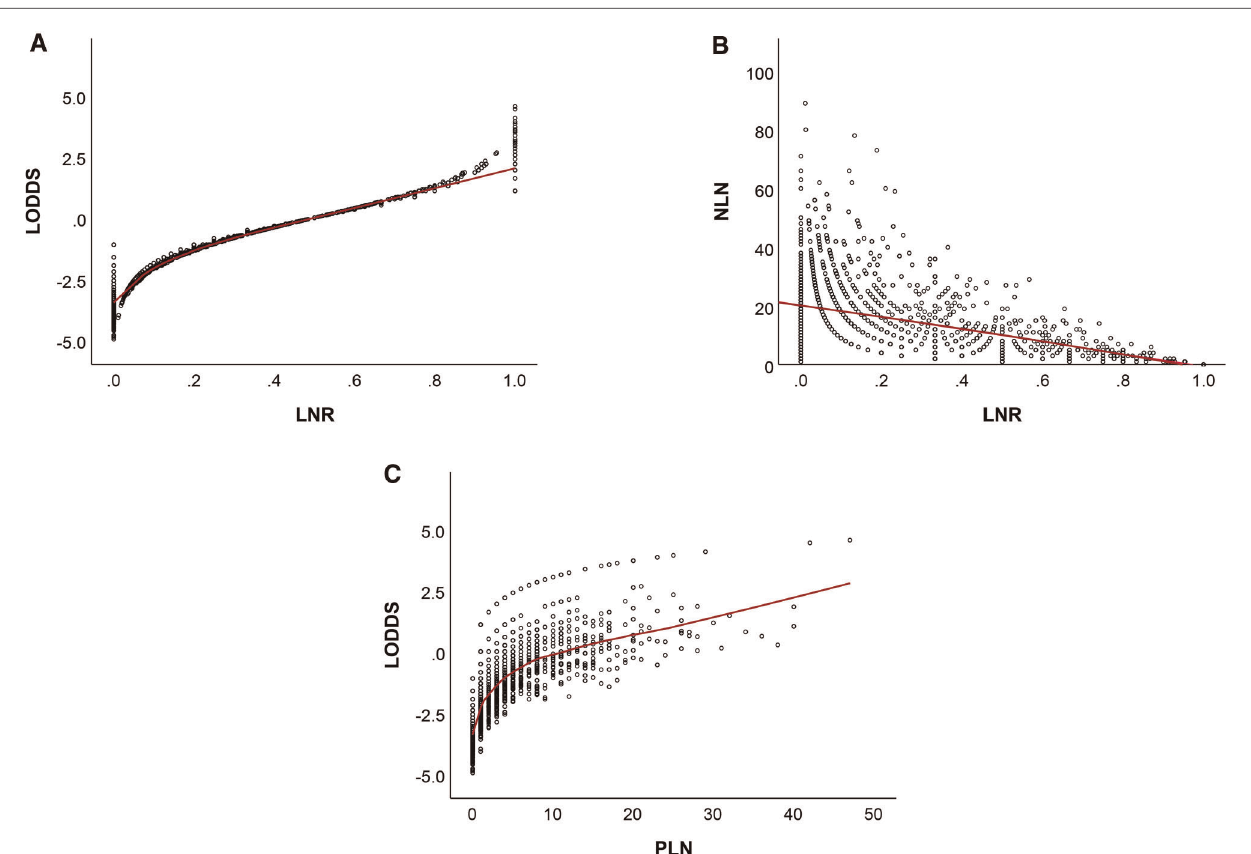
FIGURE 8 | Distribution of LNR vs LODDS ( A ), NLN ( B ), and PLN vs LODDS ( C ). LNR, lymph node ratio; LODDS, log odds of positive lymph node; NLN, negative lymph node; PLN, number of positive lymph